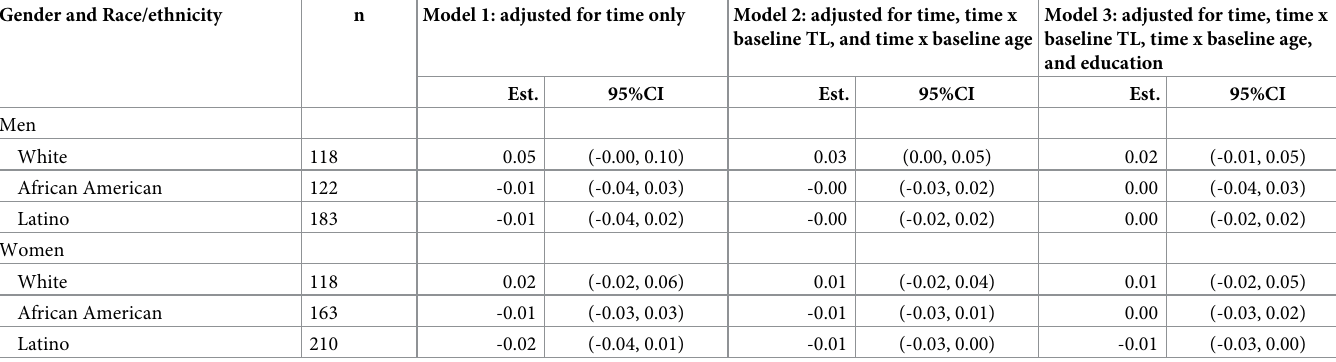
Table 2. Estimated change in 10-year telomere attrition associated with 1-SD increase in occupational complexity by gender and race/ethnicity. Gender and Race/ethnicity n Model 1: adjusted for time